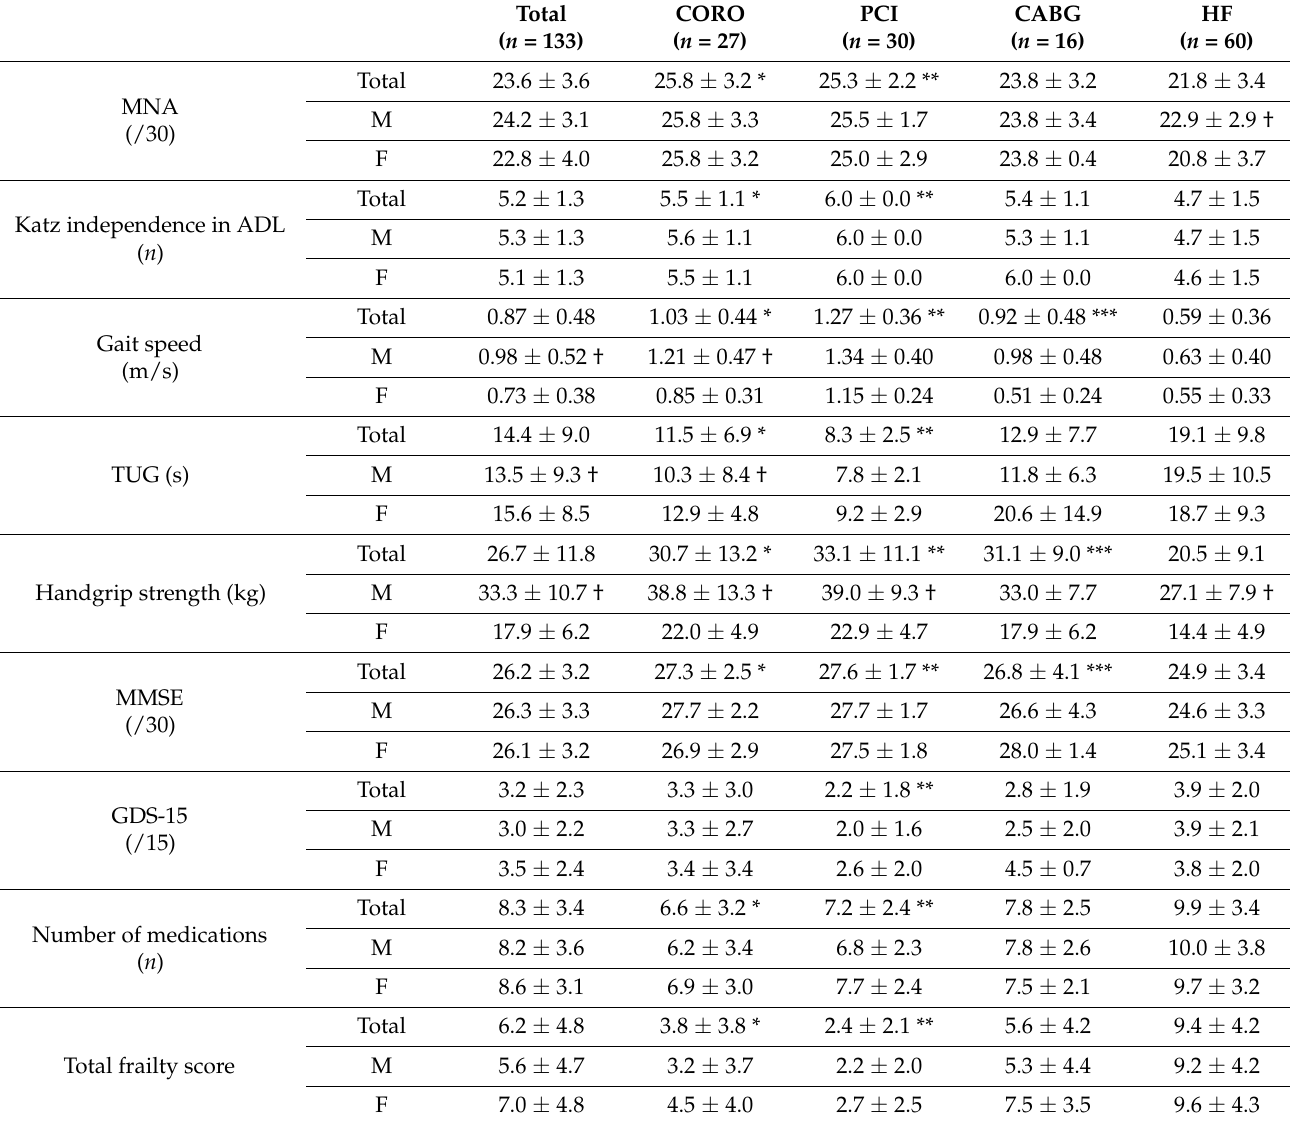
Table 4. Analysis of the frailty component scores, according to CVD and sex, based on Vigorito et al.’s frailty assessment